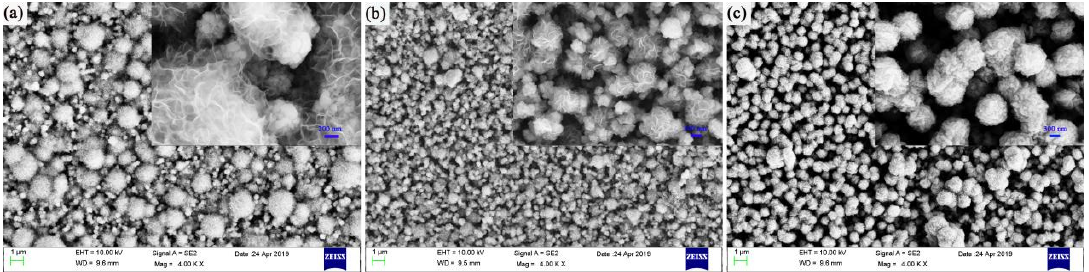
Figure 4. SEM images of the sample at different times at a reaction temperature of 220 °C and precursor amount of 30 mg. ( a ) Reaction time is 16 h; ( b ) reaction time is 20 h; and ( c ) reaction time is 24 h.